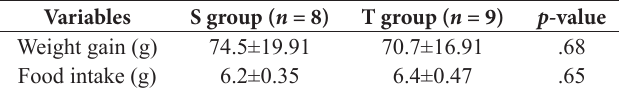
Table 2. Body weight gain (g) and individual food intake (g of feed / 100 g body weight) of rats (S and T groups) during the experimental period (mean±SD; values with p < .05 indicate significance; Student t- test